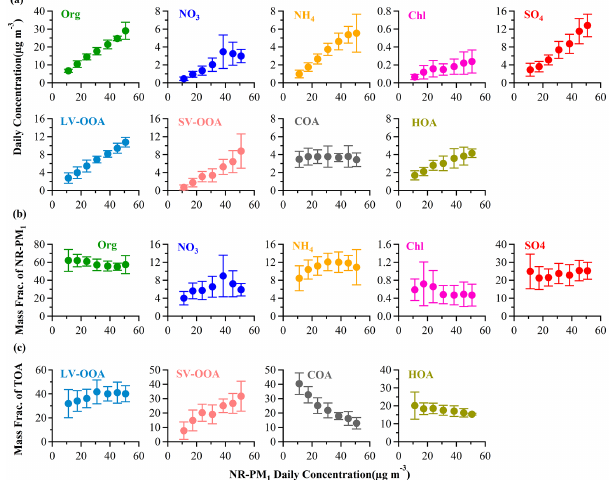
Figure 10. (a) Variation in mass concentration of NR-PM 1 species and OA components as a function of total NR-PM 1 mass loading, and (b) mass fraction of total NR-PM 1 for NR-PM 1 species as a function of total NR-PM 1 mass loading, and (c) mass fraction of total organics for OA components as a function of total NR-PM 1 mass loading. All the mass concentrations and fractions of above species were sorted according to the daily average NR-PM 1 mass in ascending order. The solid circles represent the average values for each concentration bin with a width of 7µgm − 3 , and the vertical lines represent the standard deviations.